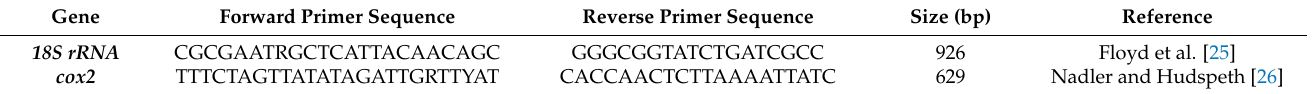
Table 1. List of the primers used in this